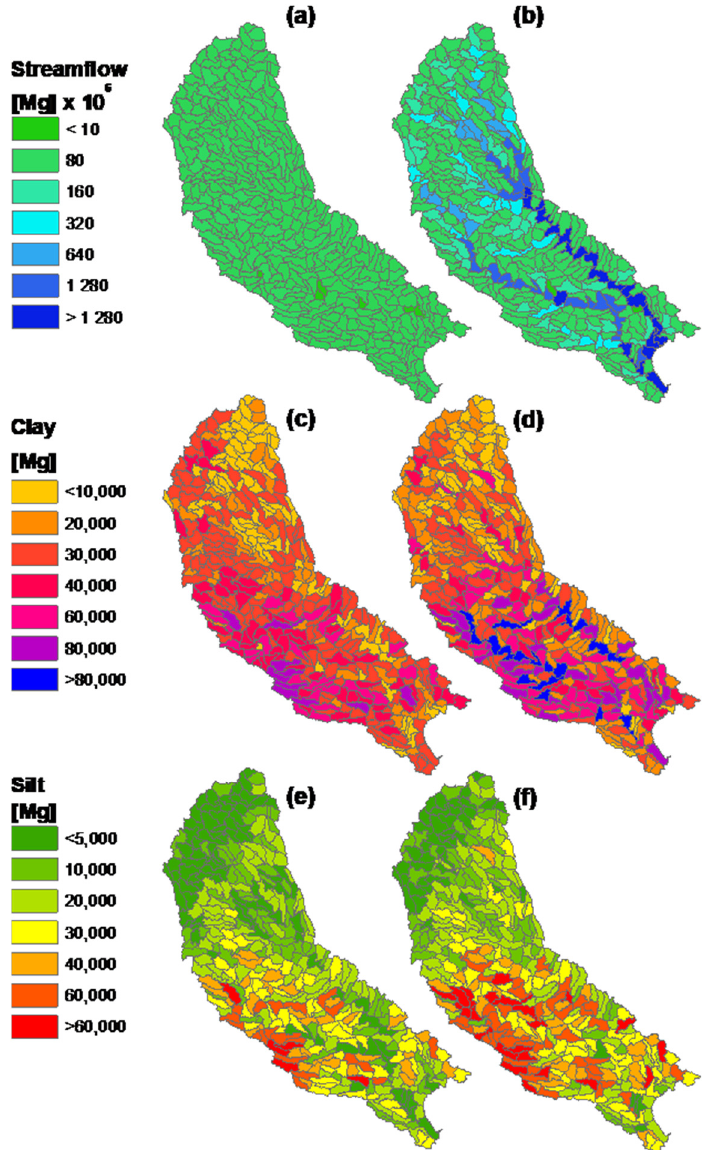
Figure 11. Annual average loads to the outlet of individual AnnAGNPS sub-watersheds displayed in corresponding HUC12s. Comparison between single ( a , c , e ) with integrated ( b , d , f ) AnnAGNPS simulations.